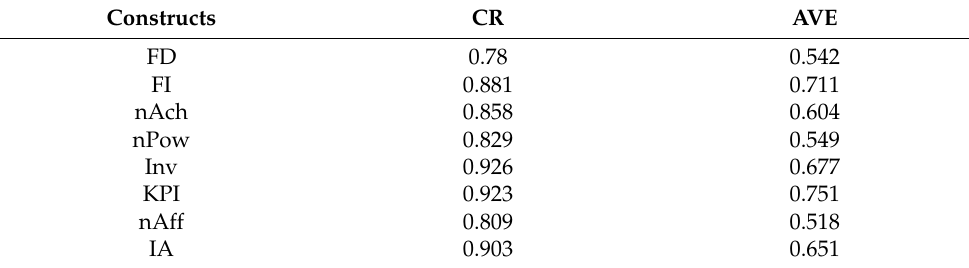
Table 3. Results of convergent validity and reliability analysis.